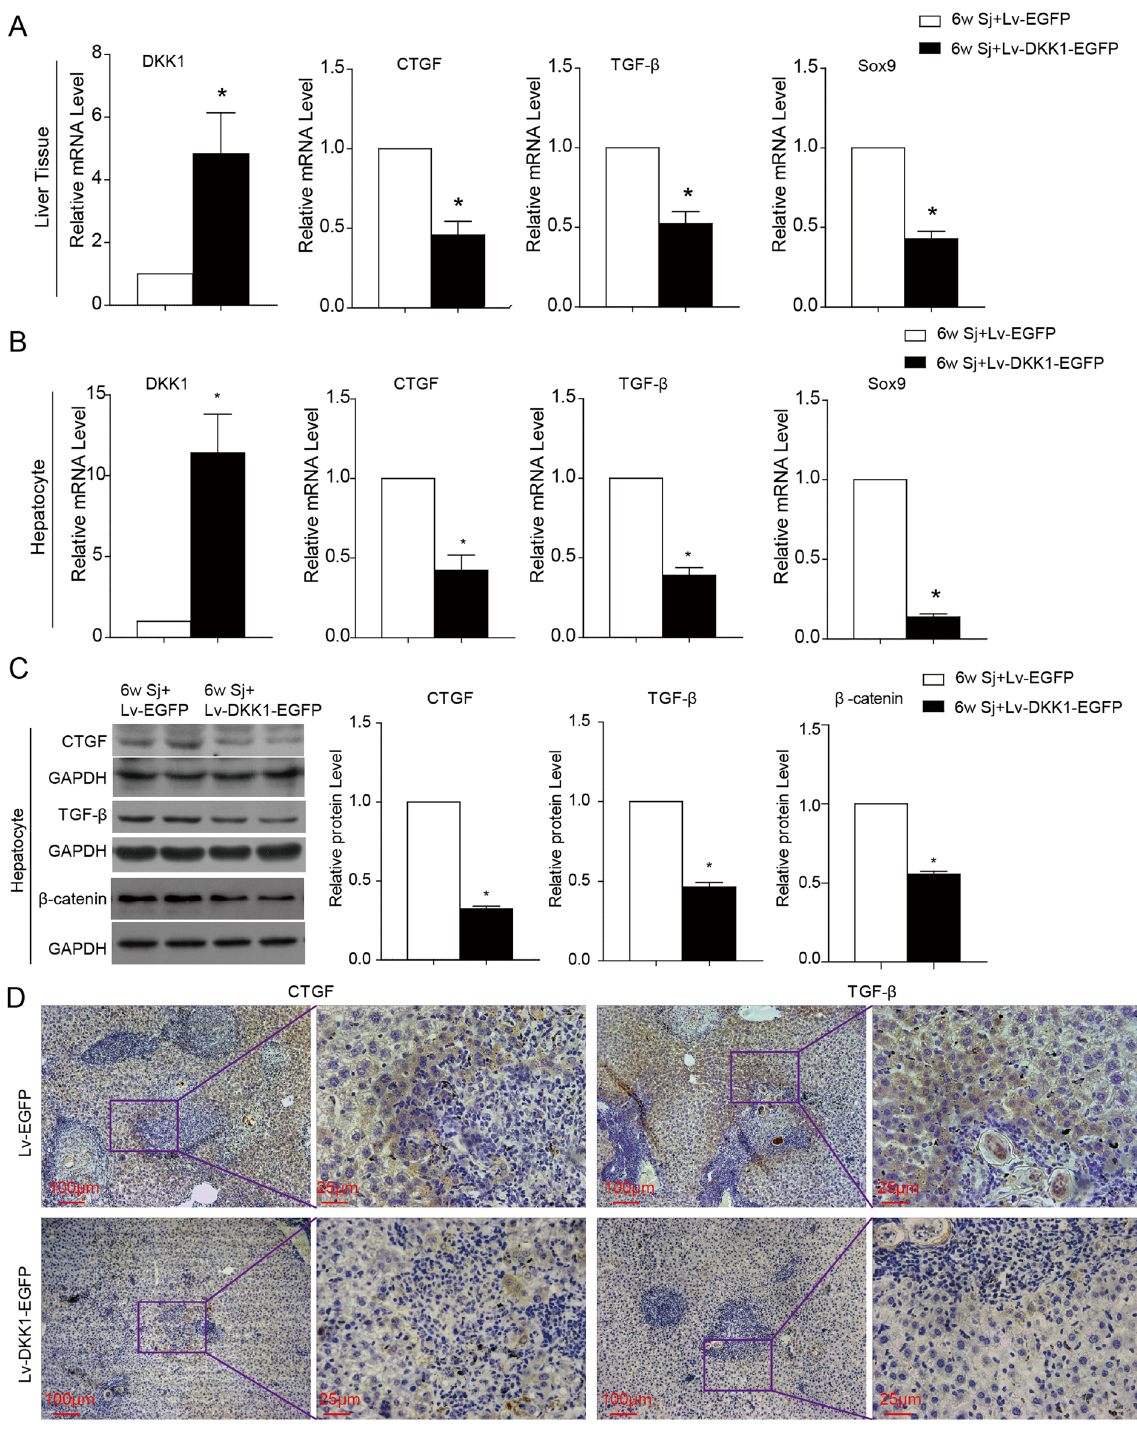
Figure 5. Dkk1 transduction inhibits the expression of CTGF and TGF- β in hepatocytes. The liver tissues ( A ) and hepatocytes ( B ) were harvested to detect the mRNA expression of CTGF, TGF- β and Sox9 by real-time PCR after Lv treatment for two weeks. ( C ) Protein expression of pro-fibrotic growth factors (CTGF, TGF- β ) and β -catenin in hepatocytes was detected by western blotting. ( D ) The expression of pro-fibrotic growth factors (CTGF and TGF- β ) in the liver was detected by immunohistochemical staining. Sj, S. japonicum . Scale bar, 100 μ m (left) and 25 μ m (right). Data represent the mean ± SEM; n = 5 ( * P <